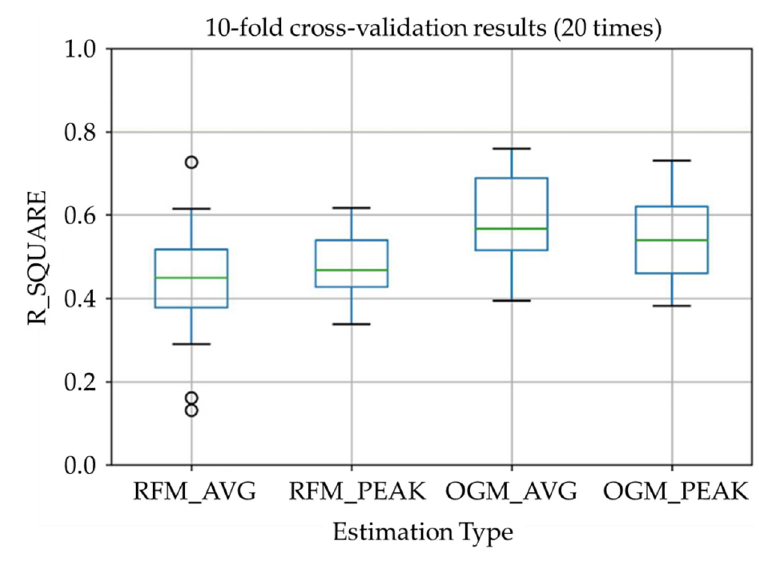
Figure 15. Model performance boxplot.